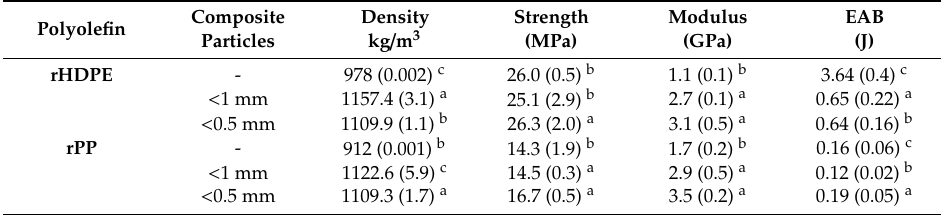
Table 1. Density and tensile properties of the polyolefins and rice hull